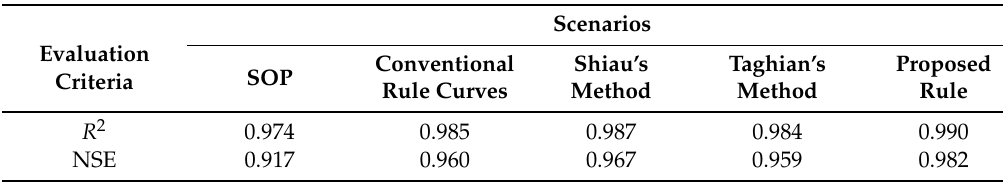
Table 5. The similarity comparison of storage process produced by dynamic programming (DP) and the other scenarios during the critical